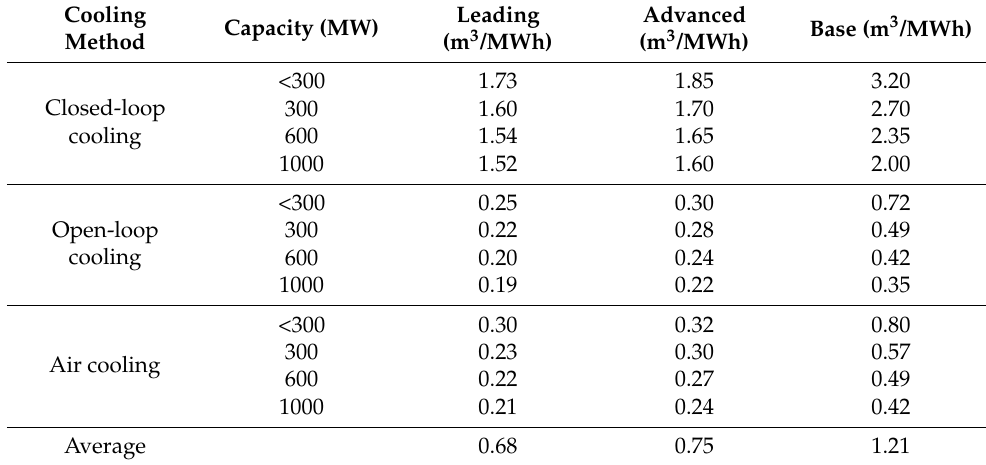
Table 7. Water consumption coefficient in coal power